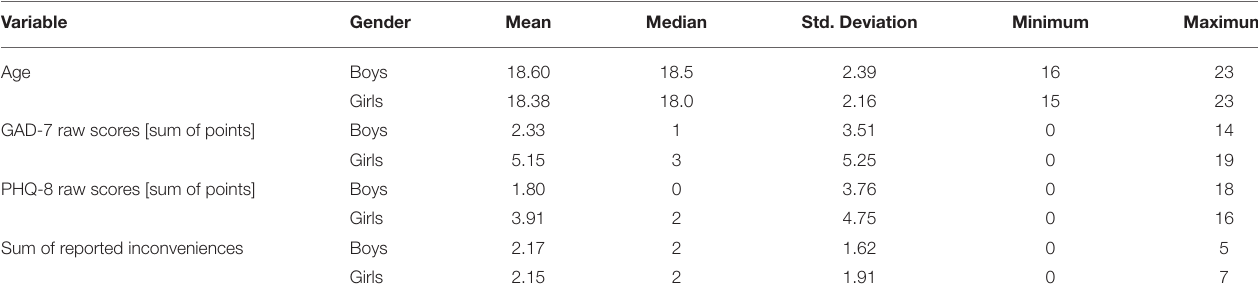
TABLE 1 | Descriptive statistics for age, GAD-7, PHQ-8, and sum of reported inconveniences. Variable